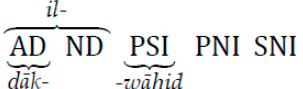
Figure 7. Reference Hierarchy for eastern Hassaniya varieties.